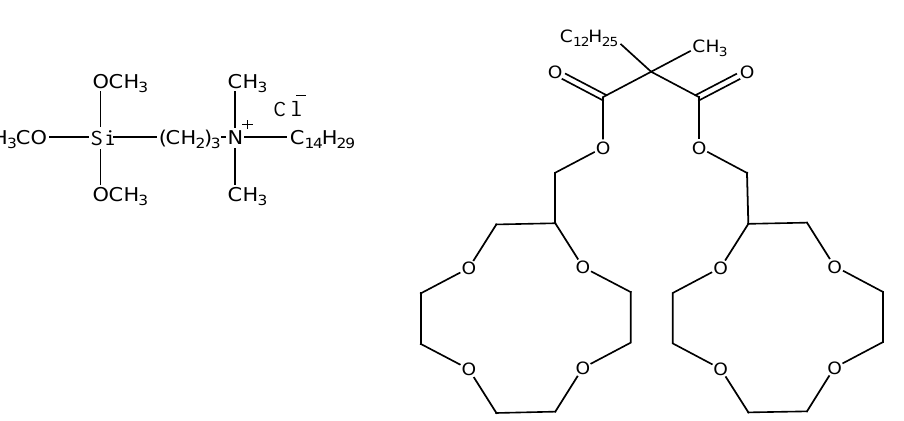
Figure 30. Quaternary ammonium salt and bis(crown ether) used to modify glass membranes for pH electrodes.